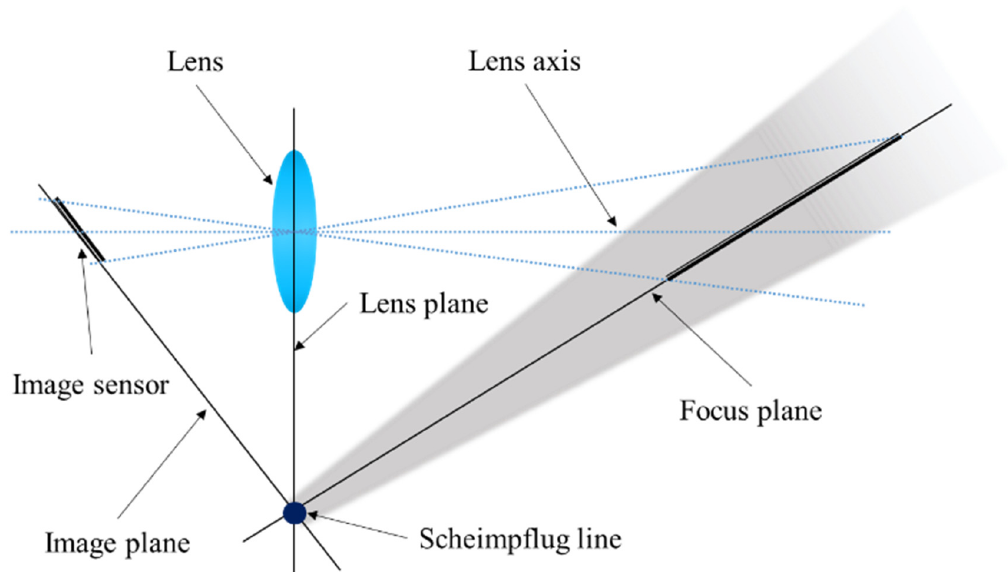
Figure 2. Scheimpflug principle in a 2D view, where gray shade represents DOF.